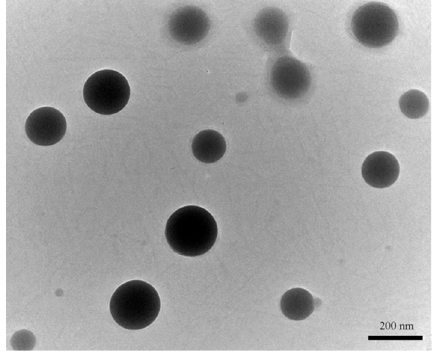
Figure 3. TEM images of DC, showing microspheres with an average diameter of 290 nm.